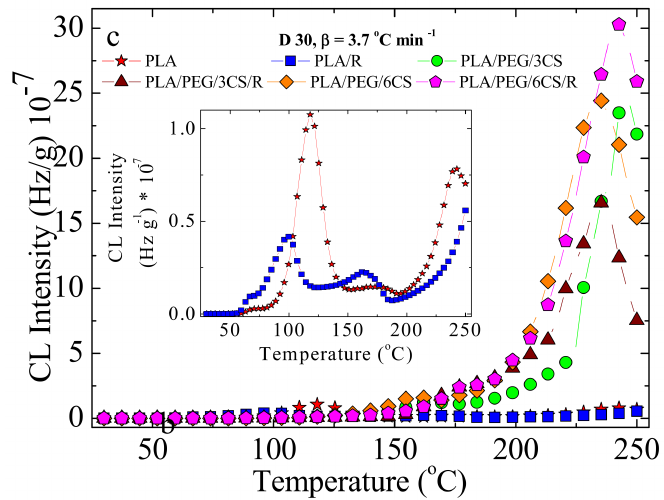
Figure 12. Nonisothermal CL spectra recorded on PLA samples stabilized with rosemary extract. Heating rate: 3.7 ◦ C/min; dose rate: 1.2 kGy/h. Additive concentrations: ( a ) 0.25 wt%; ( b ) 0.50 wt%; ( c ) 0.75 wt%. (red stars) 0 kGy; ( (cid:3) ) 10 kGy; ( ) 20 kGy; ( ∆ ) 30 (cid:35)